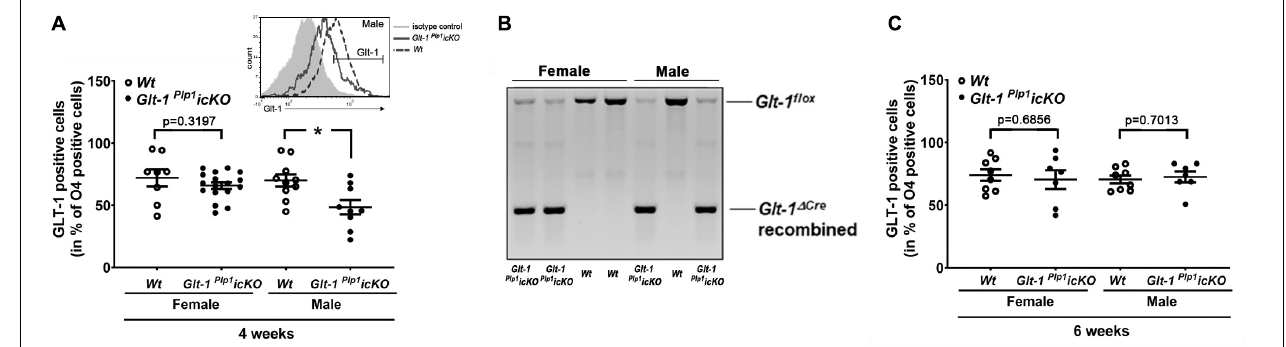
FIGURE 2 | The percentage of GLT-1-positive maturing (O4-positive) OLGs is transiently reduced in male Glt-1 Plp 1 icKO brains at 4 weeks of age. (A,C) Graphs depicting the percentage of maturing (O4-positive) OLGs with surface expression of GLT-1, as determined by flow cytometry, at 4 (A) and 6 (C) weeks of age. Glt-1 Plp 1 icKO and Wt ( Plp1 CreERT -negative littermate) mice were treated as depicted in Figure 1A and analyzed at 4 and 6 weeks of age. Dots represent individual samples (animals), horizontal lines indicate means, error bars are depicted as SEM. ∗ p ≤ 0.05, multiple comparisons, two-way ANOVA with post-hoc Tukey’s test; there is no significant interaction; individual p -values are depicted for p > 0.05. The inset in panel (A) depicts a representative histogram displaying relative fluorescence intensity (x-axis) vs. event number (y-axis) gated for O4 positivity; overlaid histogram subtraction (GLT-1 histogram—IgG isotype control histogram) was used to determine the percentage of GLT-1-positive maturing (O4-positive) OLGs. (B) Representative genomic PCR results for brain tissue taken from Glt-1 Plp 1 icKO and Wt ( Plp1 CreERT -negative littermate) female and male mice.